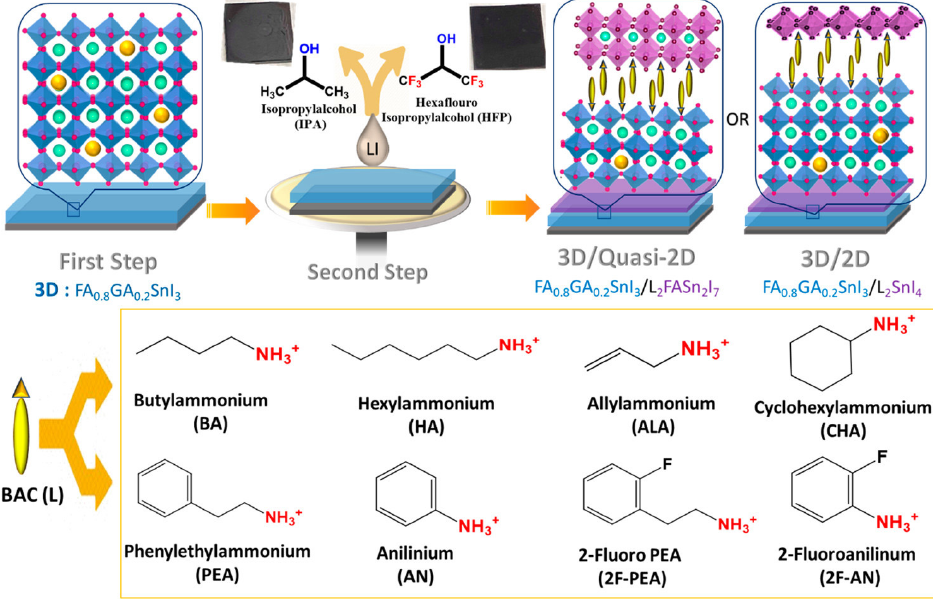
Figure 14. The process showing the fabrication of a 3D/quasi-2D Sn-PVK layer. Reproduced with permission under CC BY-NC-ND 4.0 [80]. Copyright 2021, American Chemical Society.